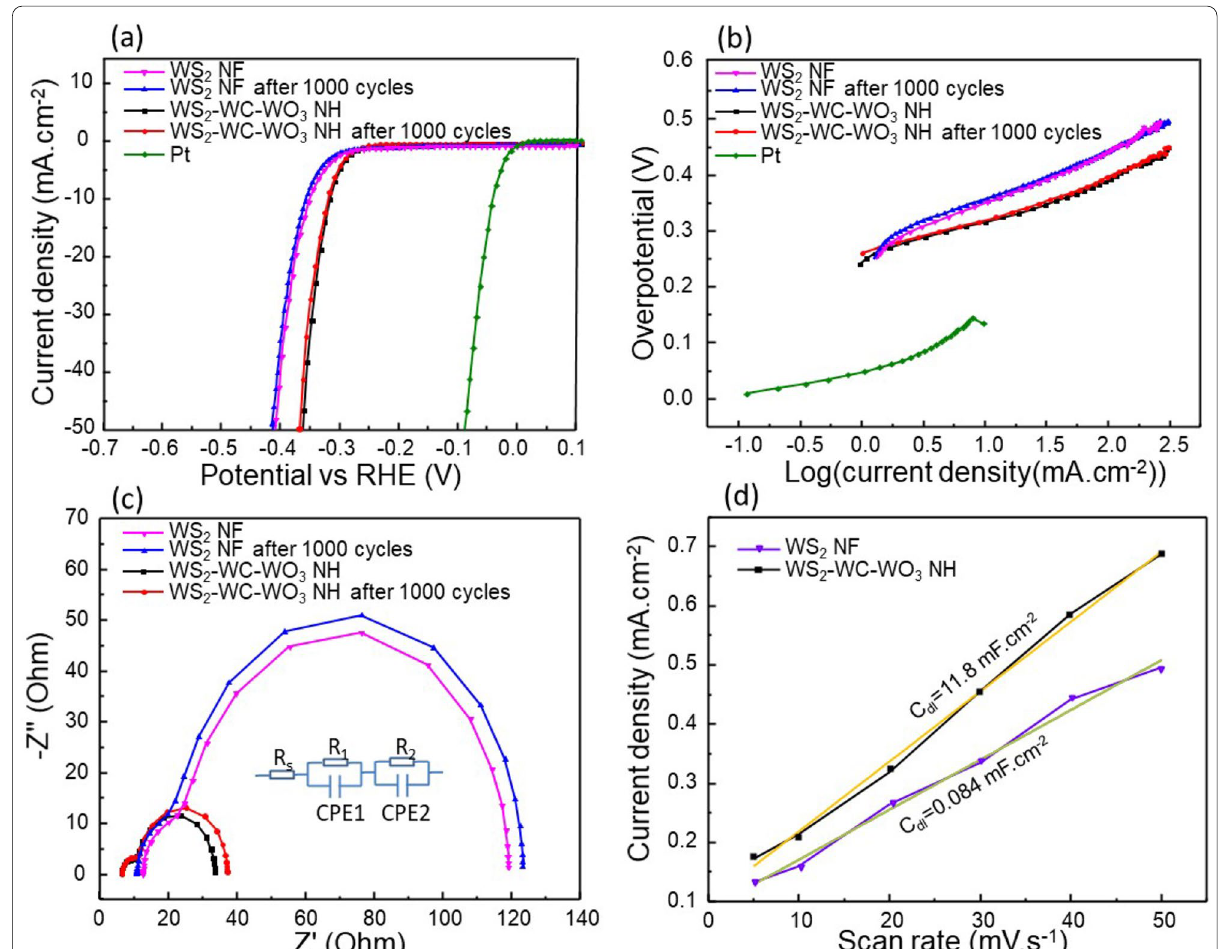
Fig. 5 HER catalytic activities of the WS 2 NF, WS 2 NF(AT), WS 2 –WC–WO 3 NH and WS 2 –WC–WO 3 NH (AT) samples. a Polarization curves of the WS 2 NF, WS 2 NF(AT), WS 2 –WC–WO 3 NH, and WS 2 –WC–WO 3 NH (AT) samples and commercial Pt/C at a scan rate of 5 mV s − 1 , b Tafel plots of the WS 2 NF, WS 2 NF(AT),